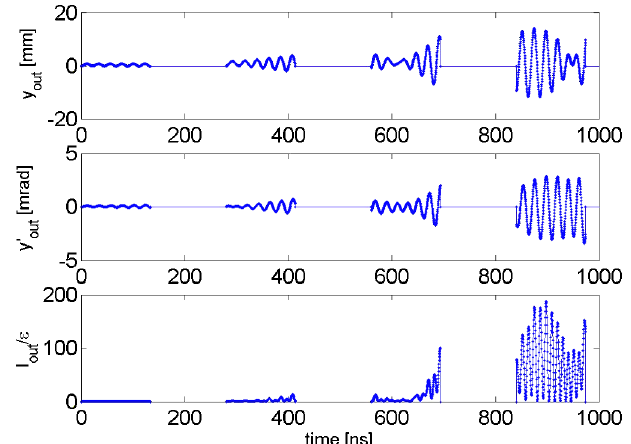
=" of a cir- out ¼ 2 mm , Y ¼ 0 , (cid:5) ¼ y 1 in1 in2 ¼ ’ ¼ 30 deg , N ¼ 12 21 bunches